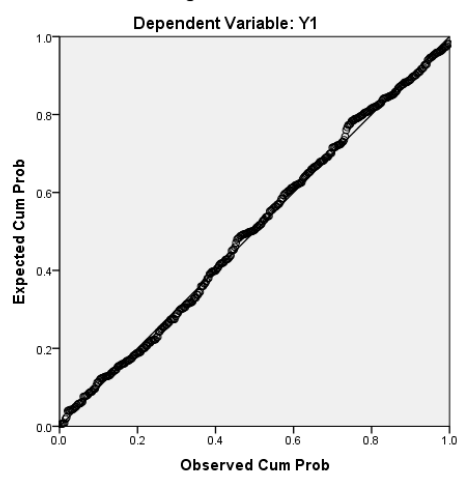
Figure 15. Normal P ‐ P plot